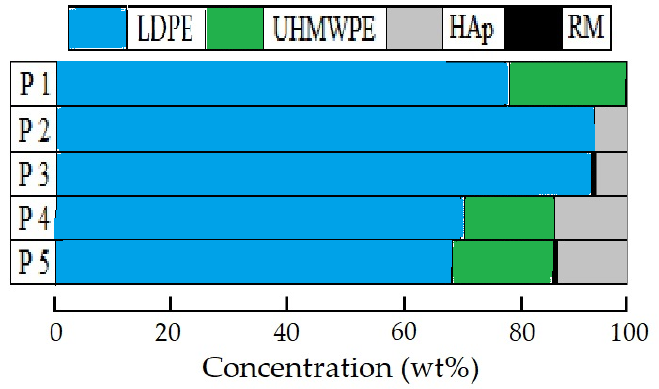
Figure 1. Illustration of component loadings for studied patterns.